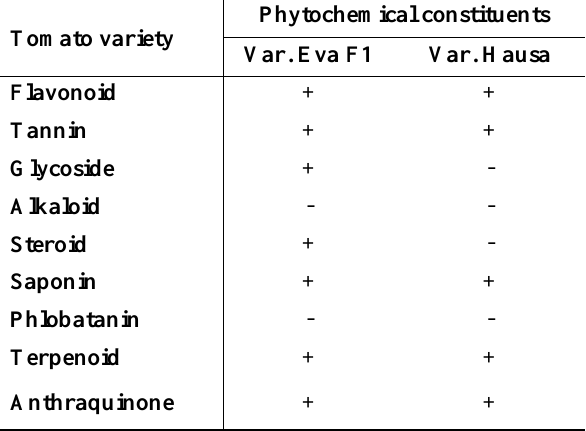
*Note: the symbol – indicates the absence of the phytochemical under investigation (hence negative), while + indicates the presence of the phytochemical under investigation (hence